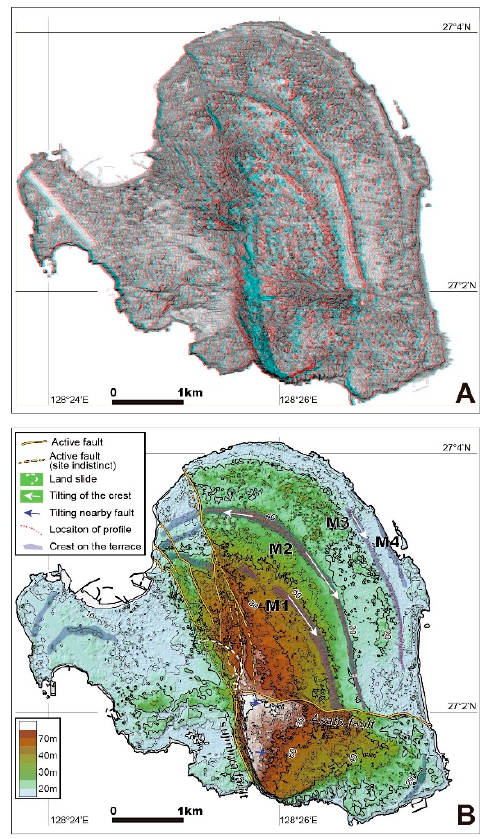
Figure 3. ( A ) Topographical anaglyph of the Yoron island; ( B ) Topographical map of the Yoron island, overlain by the active fault distribution and uplifted coral reef crests. Both ( A , B ) are based on the DSM processed using vintage photographs in this study. The labels of “M1”, “M2”, “M3”, “M4” in ( B ) are indicated the name of the marine terraces.